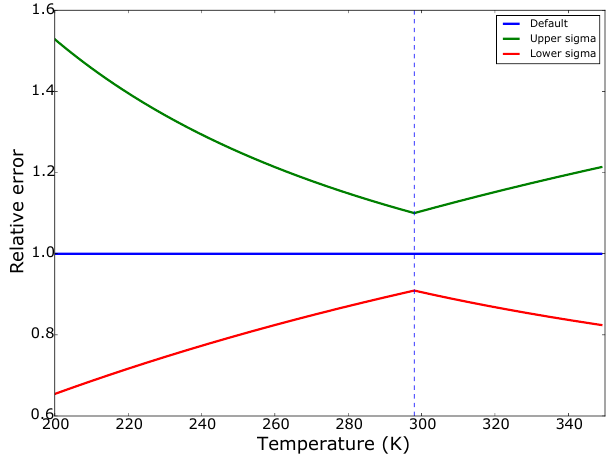
Figure 1. Example of the uncertainty on a reaction rate constant. The relative uncertainty of the reaction O 3 + NO is plotted as a function of temperature. The lowest uncertainty is at room temper- ature (298K) with exponentially increasing uncertainties occurring as we diverge to higher and lower